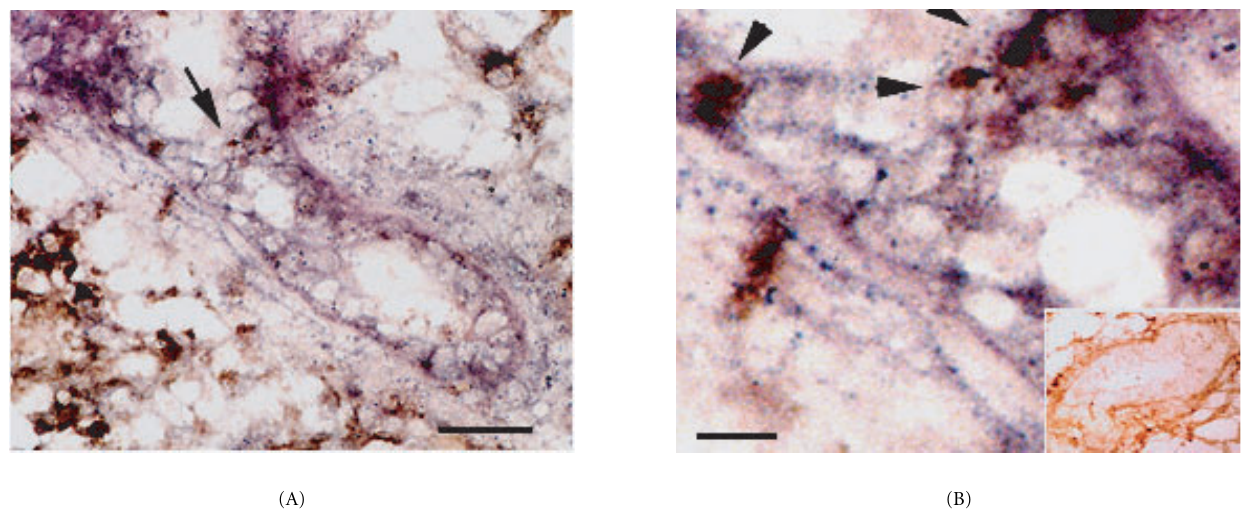
Figure 4: Colocalization of α -catenin mRNA, protein and BrdU/TLC positivity in 8 week-old C57 Bl6N aged mammary duct. (A–B) Detection of α -catenin mRNA (blue) and BrdU immunostaining (brown) in mammary ducts hybridized to a digoxigenin-UTP labeled α -catenin probe. (B) Area highlighted in (A) (arrow) under high magnification. Note brightly stained BrdU cells are arranged as TUs and appear to be located just proximal to the subtending duct. Inset in (B) represents control section for BrdU staining (secondary antibody alone). Scale bar in (A), 660 µ m, and (B), 260 µ m.